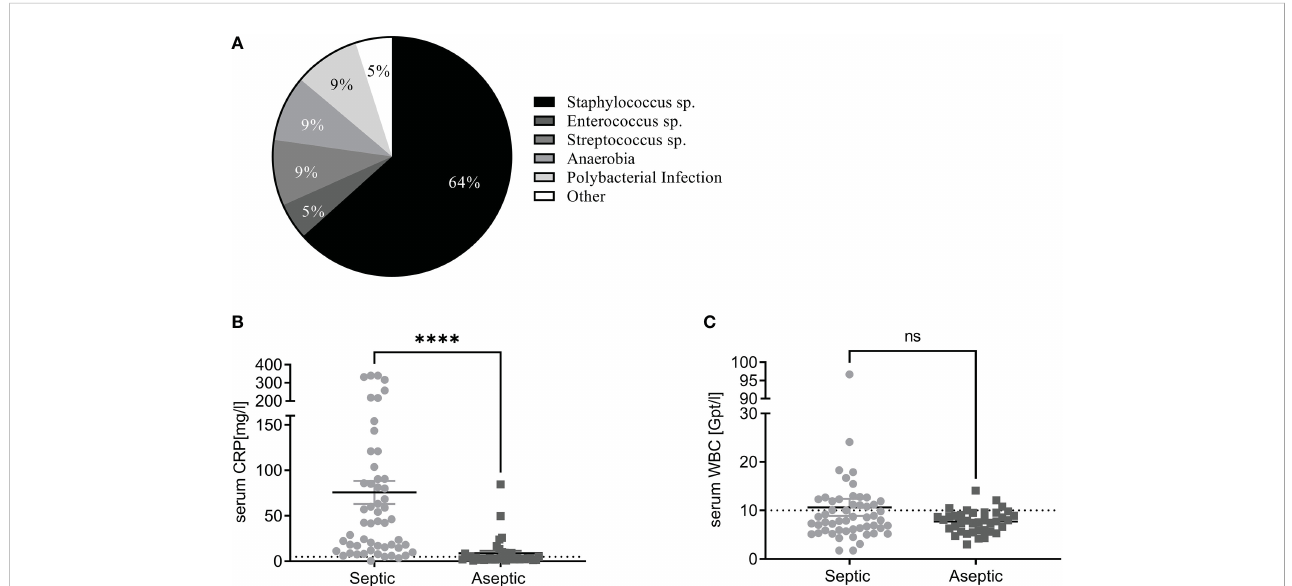
FIGURE 1 Serum CRP and WBC count are indicators for periprosthetic joint infection (A) Pie chart of the identi fi ed pathogen spectrum. Staphylococcus spp. was the major pathogen that was identi fi ed by the microbiological diagnostic. Other bacteria were less frequently detected. (B) Serum C-reactive protein (CRP) values (mg/l) in septic (light grey) and aseptic (dark grey) groups. The serum CRP value of the septic cohort was signi fi cantly increased in the septic compared with the aseptic cohort (Mann-Whitney test: p<0.0001). The pathologic threshold is 5mg/L is indicated as a black dashed line. (C) The mean value of the serum white blood cell (WBC) count (Gpt/l) was not different between both cohorts (Mann-Whitney test: p= 0.237). Most patients exhibited a WBC count below the pathological threshold of 10 Gpt/l (black dashed line) for all tested groups. ****P < 0.0001, ns, not signi fi cant.